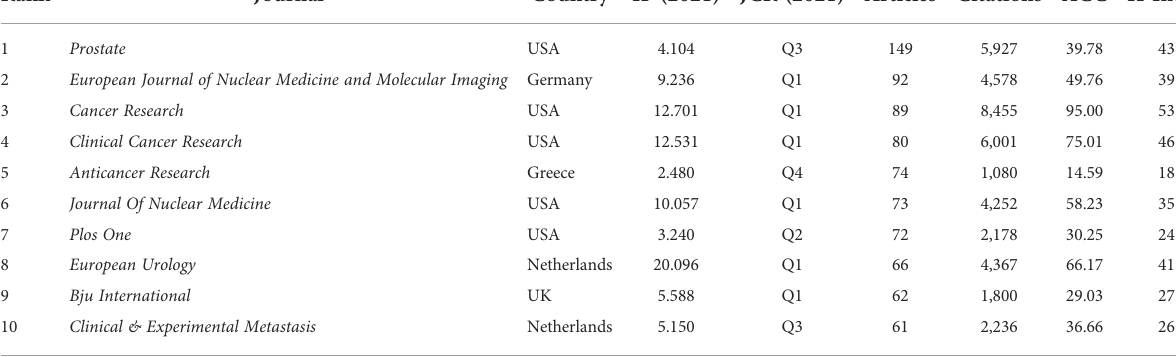
TABLE 4 The top 10 journals with the most articles associated with bone metastases in prostate cancer.